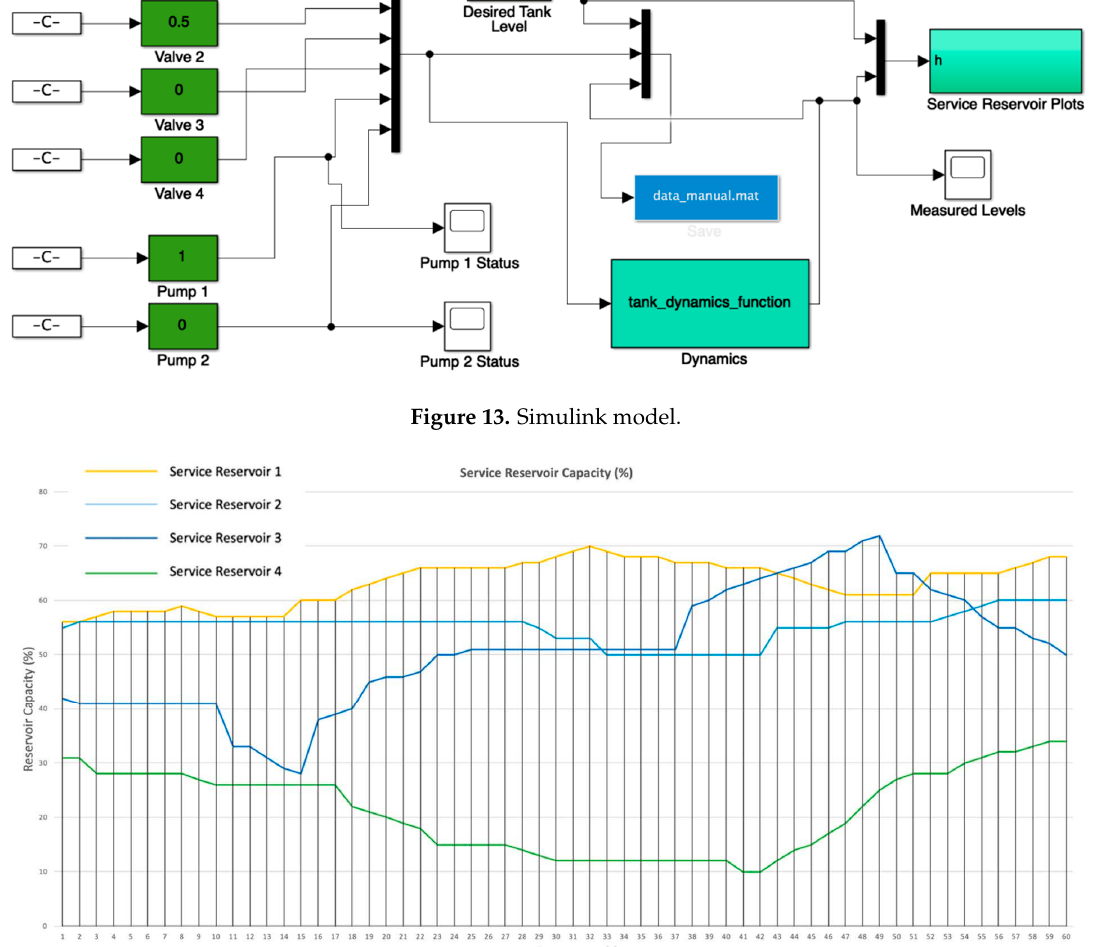
Figure 14. Service reservoir capacity from simulation run .